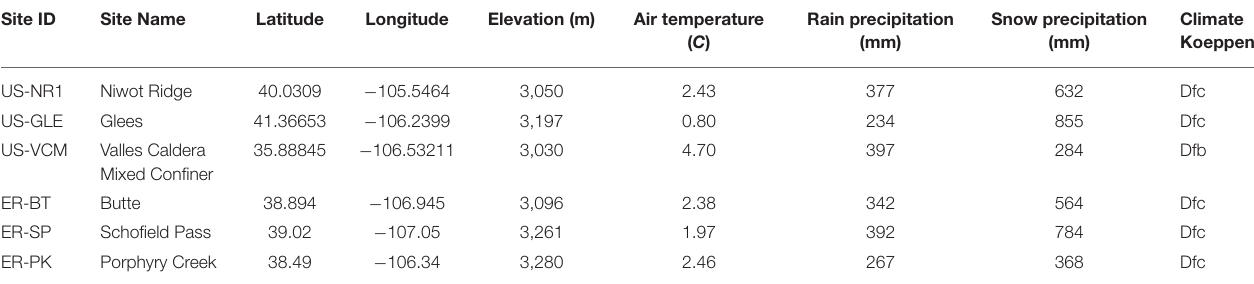
TABLE 1 | Summary characteristics of the six sites selected in this study. Site